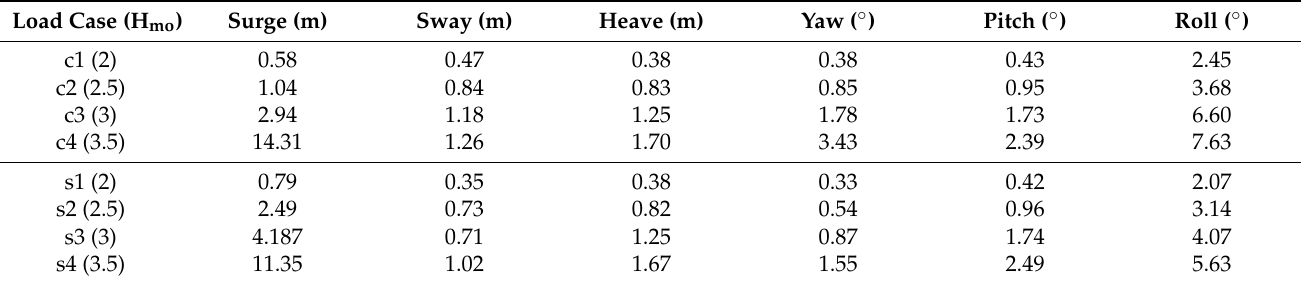
Table 7. Maximal motions in each degree of freedom per load case.